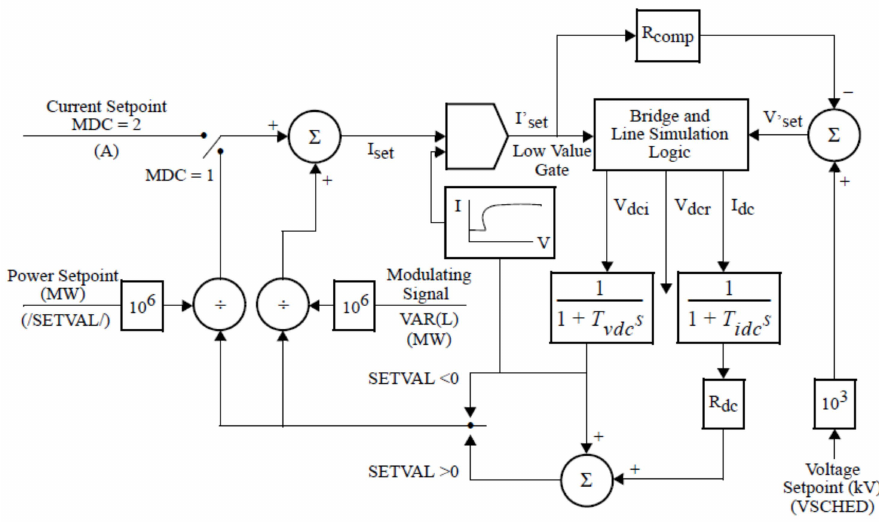
Figure 6. CDC4T-DC transmission line control model.